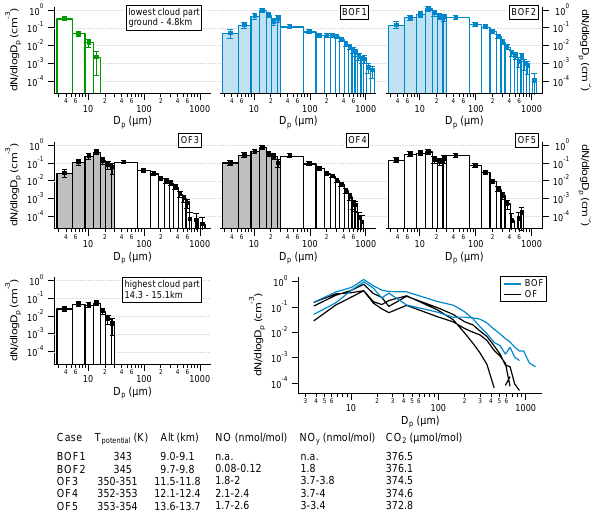
2006 along with altitude and tracer mixing ratio information. The blue size distributions are compiled from measurements below the outflow (“BOF1” and “BOF2”) and the black ones inside the out- flow. The lower right panel summarises the ice particle size dis- tributions from below and inside the outflow for comparison. The particle size distributions of the lowest and highest cloud parts are measured by the FSSP-100 only. The shading in the FSSP-100 size range indicates potential shattering contamination.